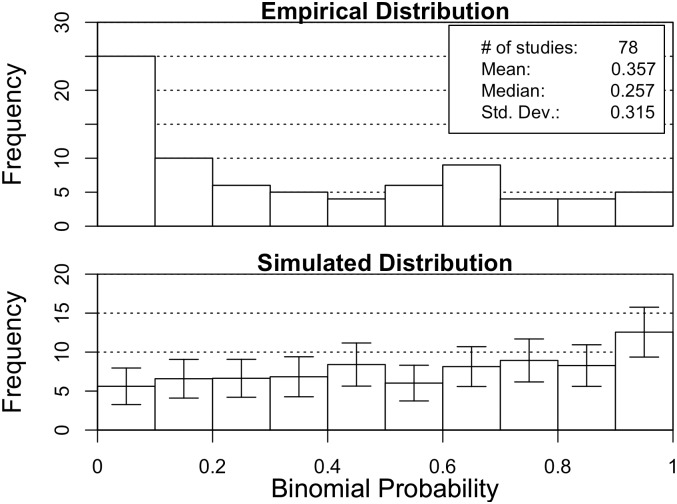
Distribution of binomial P-values.Upper pane: the experimental GF database. Lower pane: Simulated Null-distribution.